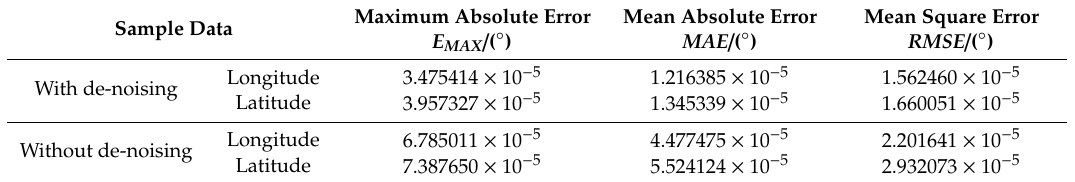
Table 4. Comparison of trajectory sequence prediction errors with and without de-noising.